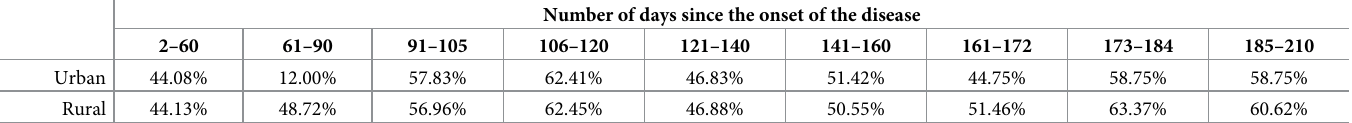
Table 4. Summary of percentage change in R o under the implementations of different NPIs with different adherence levels in the urban and rural population of Ethiopia during the first 7 months of the pandemic.